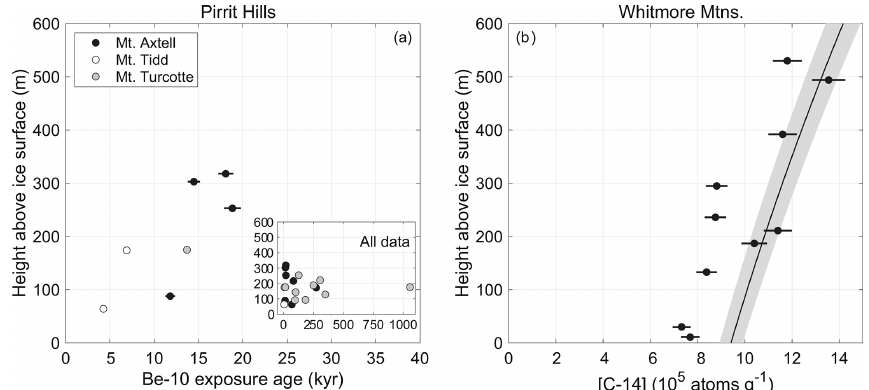
Figure 5. (a) Beryllium-10 exposure age of erratics from the Pirrit Hills plotted against their height above the modern ice surface. Inset shows the apparent ages of all glacial deposits, the majority of which are preexposed. (b) Carbon-14 concentrations in bedrock samples from the Whitmore Mountains plotted against their height above the modern ice surface. The black line and surrounding gray band represent calculated 14 C saturation concentrations, which are a function of elevation, and their uncertainty. As discussed in the text, 14 C saturation occurs after ∼ 30–35kyr of continuous exposure, at which point nuclide production is balanced by decay, and the 14 C concentration is no longer time dependent. Error bars for both (a) and (b) are 1 standard